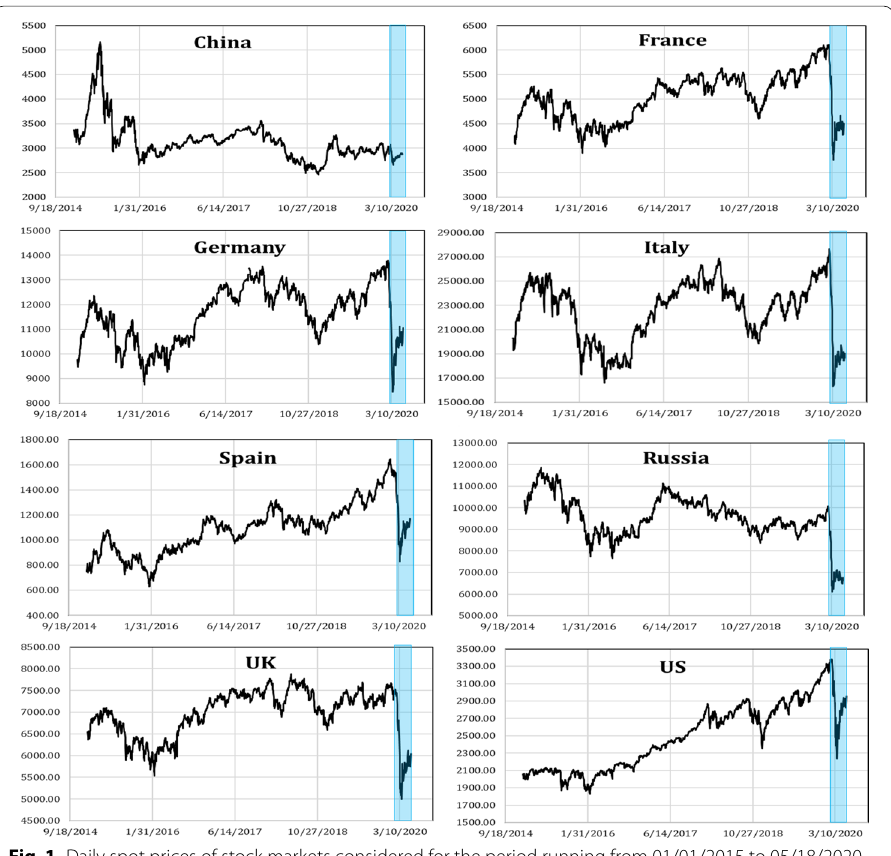
Fig. 1 Daily spot prices of stock markets considered for the period running from 01/01/2015 to 05/18/2020. The shaded area indicates the period of the COVID-19